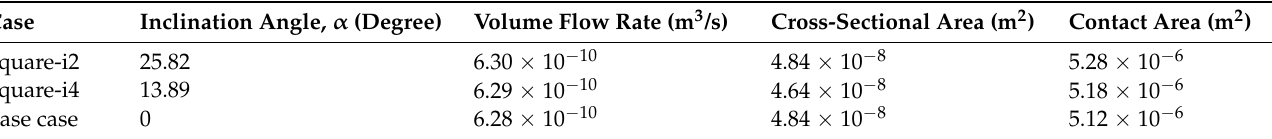
Table 12. Volume flow rate and contact area of slanted microchannels with square